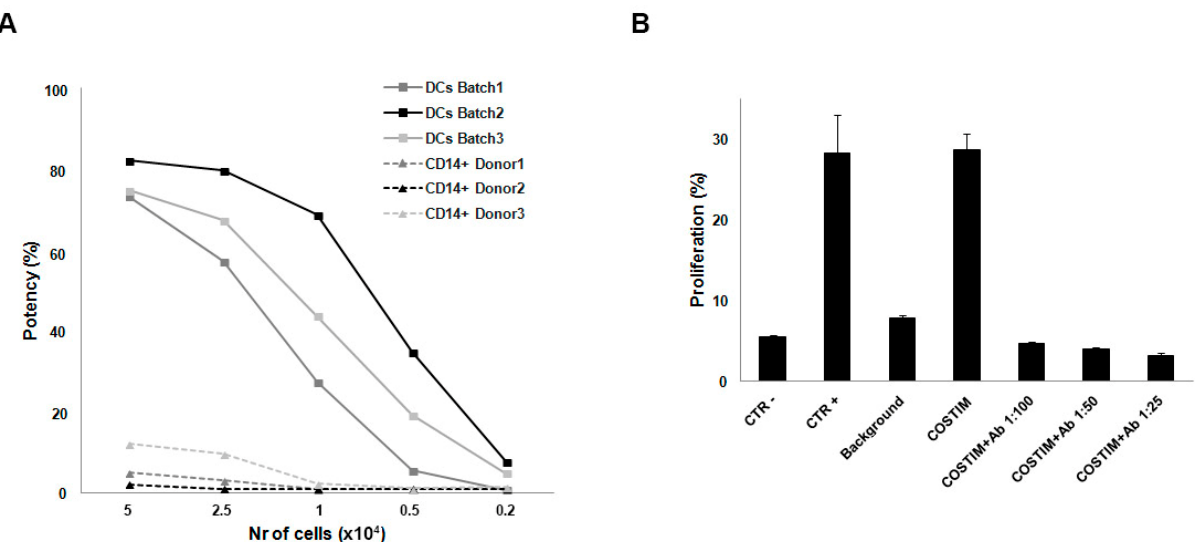
Figure 2. Specificity of the bioassay. ( A ) Potency induced by varying numbers of DCs or monocytes per well. Data from three batches and donors are reported. ( B ) Proliferation with and without different concentrations of the antibody (Ab) cocktail (anti-CD54, anti-CD80, and anti-CD86). Results are mean ± SD of three experiments. The addition of the isotopic controls does not modify the DC-induced T cell proliferation at any concentration.